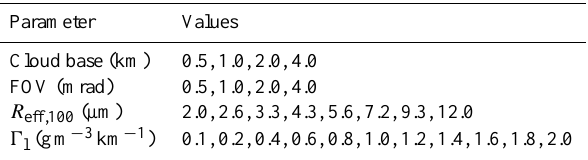
Table 1. Range of parameters used in the MC calculations. Parameter